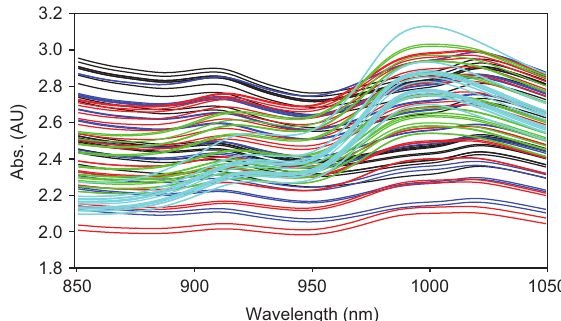
Figure 1 The raw absorbance spectra of mixtures of gluten and starch powder with different weight ratios (black lines, 1:0; blue lines, 0.75:0.25; red lines, 0.5:0.5; green lines, 0.25:0.75; cyan lines, 0:1). (Reprinted with permission from Z.P. Chen et al. Anal. Chem.